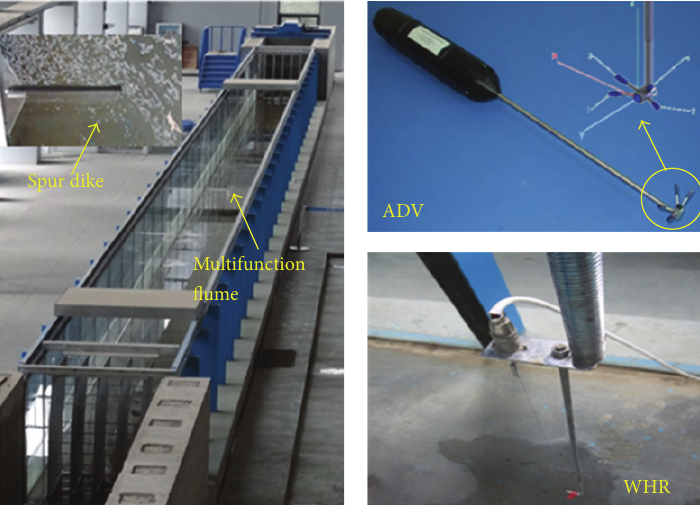
Figure 1: Multifunction flume and measuring instruments.